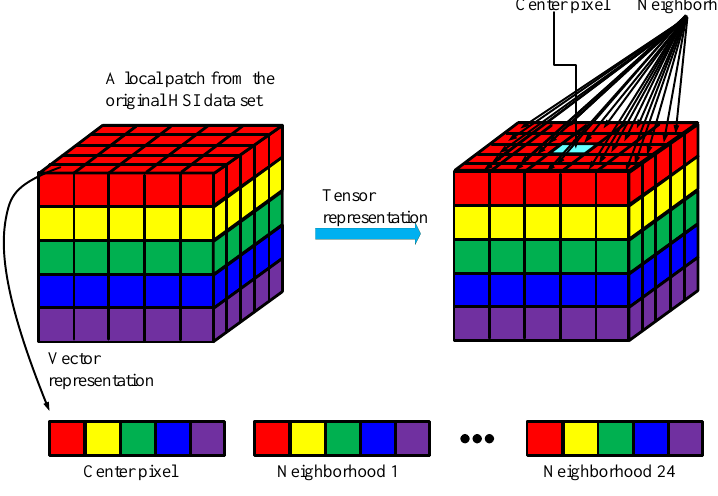
Figure 1. Vector and tensor representations of a 5 × 5 local patch from the original HSI data